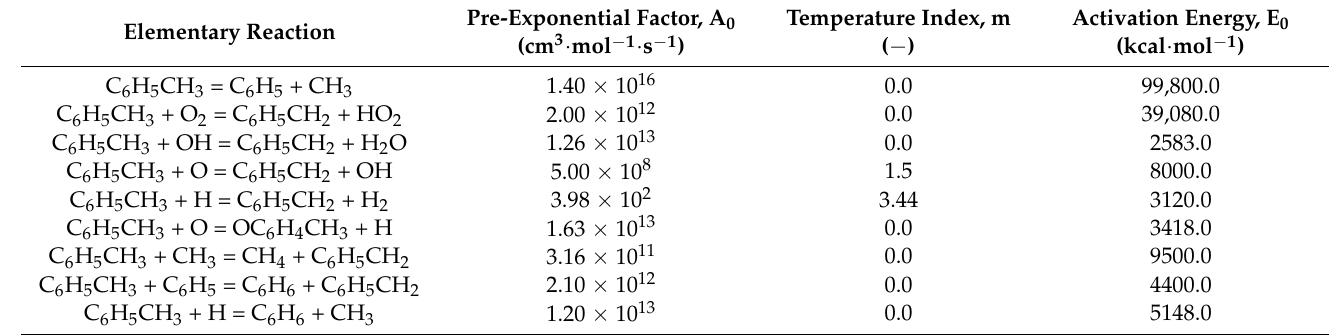
Table A3. Elementary reactions and chemical reaction kinetic parameters related to the C 7 H 8 [25].